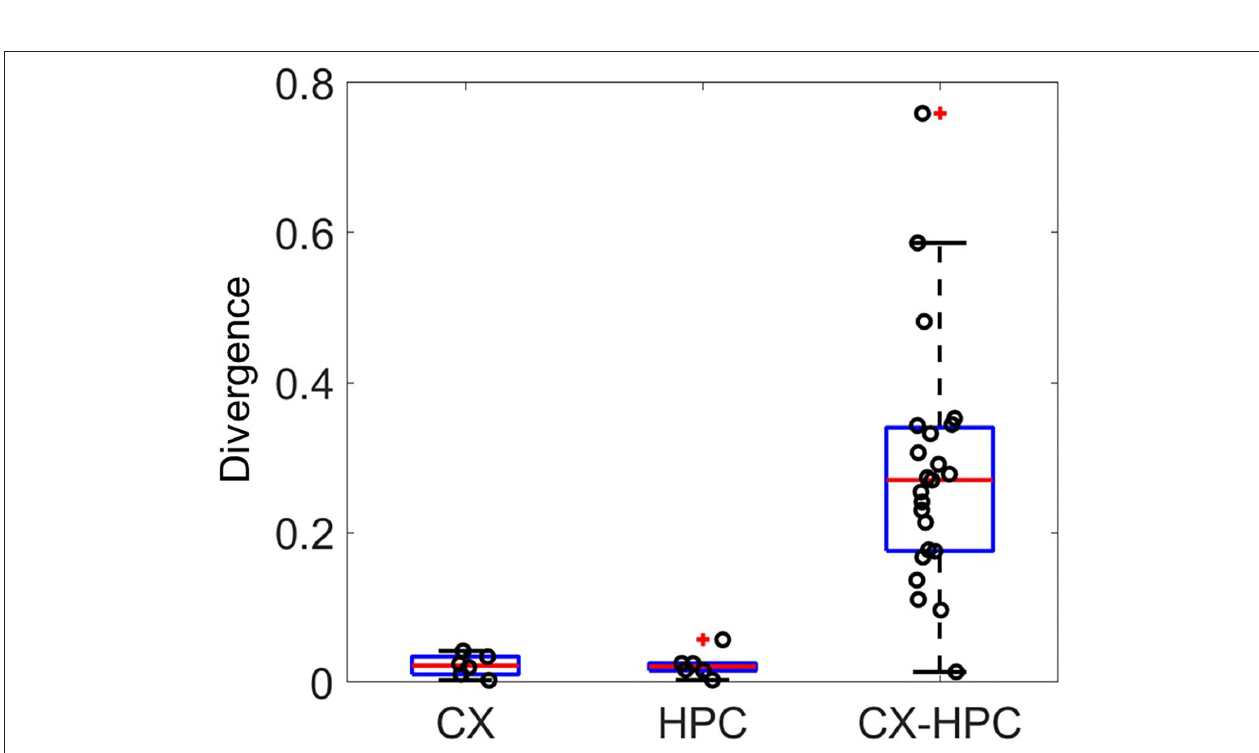
FIGURE 5 | The Kullback–Leibler divergence (KLD) of the distribution of inter-spike intervals between electrodes in different culture chambers. The KLD in homogeneous cocultures of CX and HPC neurons are lower than those in heterogeneous neocortical-hippocampal (CX-HPC) coculture samples, suggesting that activity-rhythm differences between network types are maintained in the heterogeneous